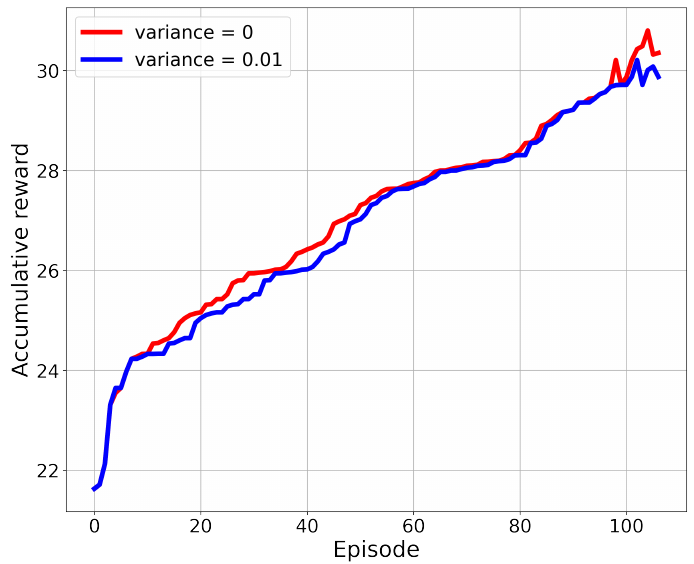
Figure 6. Accumulated reward over the number of